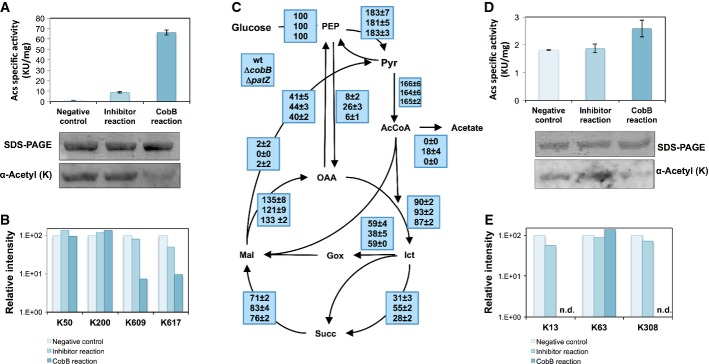
Regulation of acetate metabolism enzymes by lysine acetylationA, B In vitro deacetylation assays of acetyl-CoA synthetase (Acs).
Affinity-purified enzymes were deacetylated with purified CobB. Negative controls were performed in
the absence of CobB and in the presence of the CobB inhibitor nicotinamide (NAM). The effect of
deacetylation was assessed by specific enzyme activity assays, Western blotting using an
anti-acetyl-lysine antibody (A) and mass spectrometry (B). Relative intensities of the acetylated
peptides found in each deacetylation reaction are shown for Acs in (B). Peptide intensities were
normalized.C Metabolic fluxes in 13C-labeled glucose-limited chemostat cultures run at D =
0.2 h−1. Fluxes are normalized to the glucose uptake rate (100%). Glucose
uptake flux (mmol/g/h) was 8.66 ± 0.21 in the wild-type strain, 9.08 ± 0.06 in the
ΔcobB mutant and 8.17 ± 0.01 in ΔpatZ mutant.
Chemostat cultures were carried out in triplicate.D, E In vitro deacetylation assays of isocitrate lyase (AceA). Affinity-purified
enzymes were deacetylated with purified CobB. Negative controls were performed in the absence of
CobB and in the presence of the CobB inhibitor nicotinamide (NAM). The effect of deacetylation was
assessed by specific enzyme activity assays, Western blotting using an anti-acetyl-lysine antibody
(D) and mass spectrometry (E). Relative intensities of the acetylated peptides found in each
deacetylation reaction are shown for AceA in (E). Peptide intensities were normalized.Source data are available online for this figure.